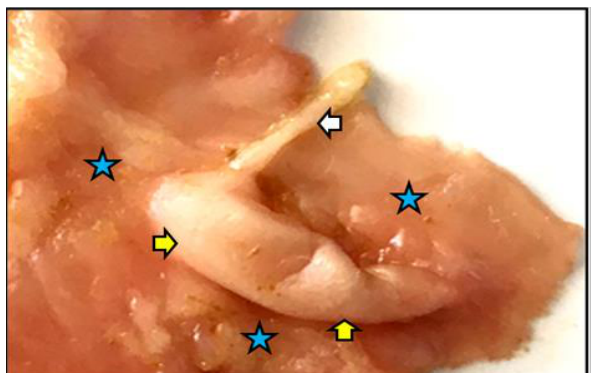
Figure 9. Common bile duct (white arrow) opened through ampulla (yellow arrows) present on the wall of 1st flexure of the duodenum (blue stars ).